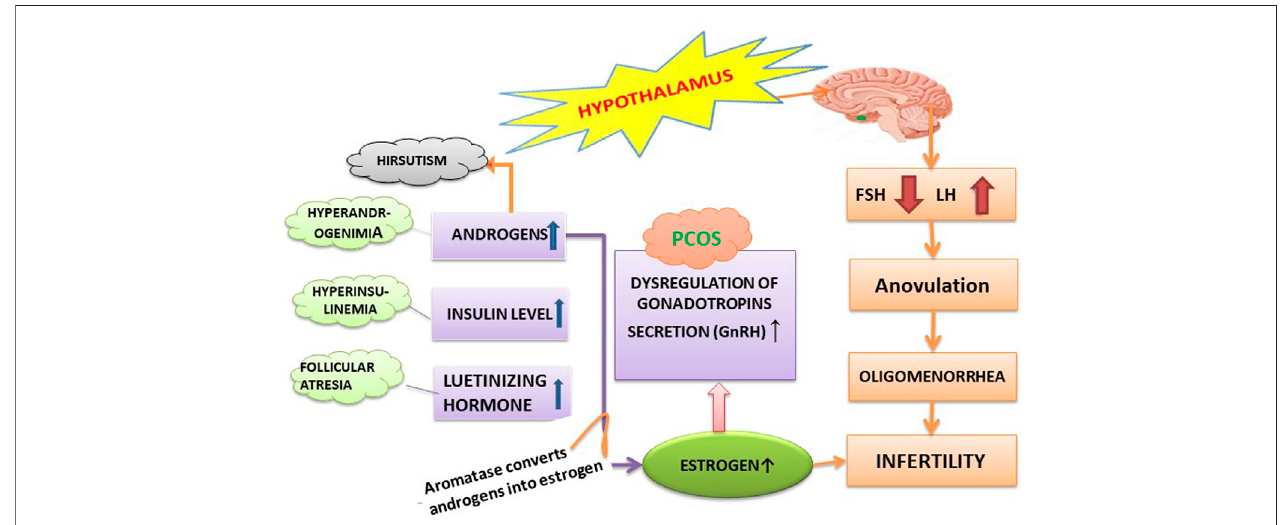
FIGURE 3 | Hormonal imbalance associated with